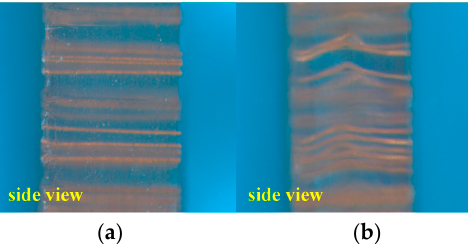
Figure 26. ( a ) ACP with embedded pins: virgin state ( b ) after one contact cycle under increased contact force.